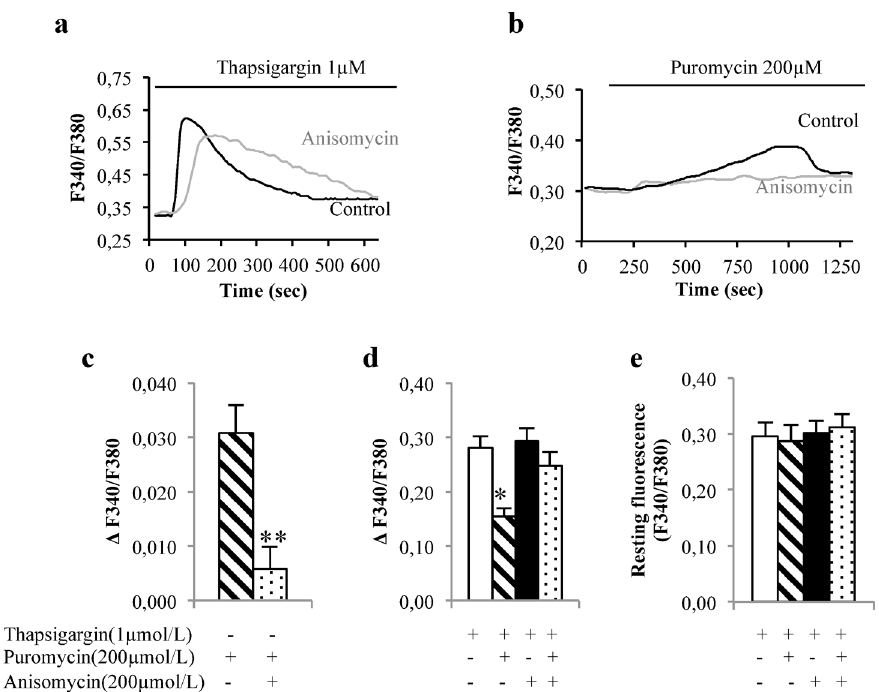
Fig 1. Puromycin and anisomycin acute effects on calcium homeostasis in human islets. Puromycin and anisomcyin effects were evaluated in 4 different human islets preparation (44 different cells) ( a - e ). Typical cytosolic calcium traces in response to 200 μ M thapsigargin ( a ) or to 1 μ M puromycin ( b ) under control conditions and after 30 min incubation with 200 μ M anisomycin. Cumulative data of peak cytosolic calcium increases evoked by puromycin responses under control conditions and with anisomycin 200 μ M ( c ). Cumulative data of peak cytosolic calcium increases evoked by thapsigargin responses ( d ) and ( e ) resting fluorescence (F340/F380) under control conditions ± puromycin or anisomycin pretreatment. * p < 0.05, ** p < 0.01. Measures were assessed in a calcium-free medium. Preparations were done in duplicate.